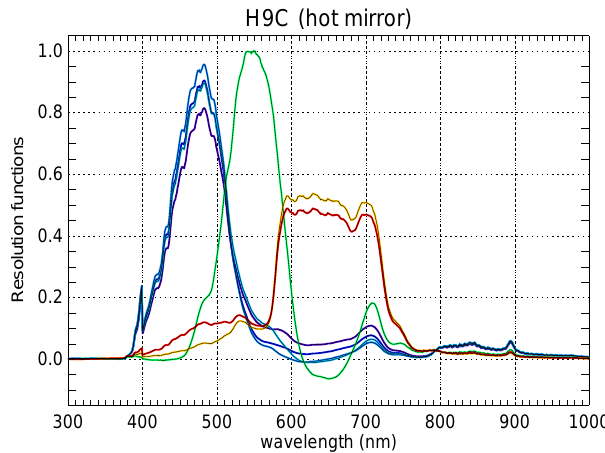
Figure 10. Resolution/window functions ( A ) for ICX285AQ with smoothing parameter µ = 1 and retrieved wavelengths of 391.4 (dark blue), 427.8 (blue), 470.9 (light blue), 486.1 (cyan), 557.7 (green), 630.0 (orange), and 777.7nm